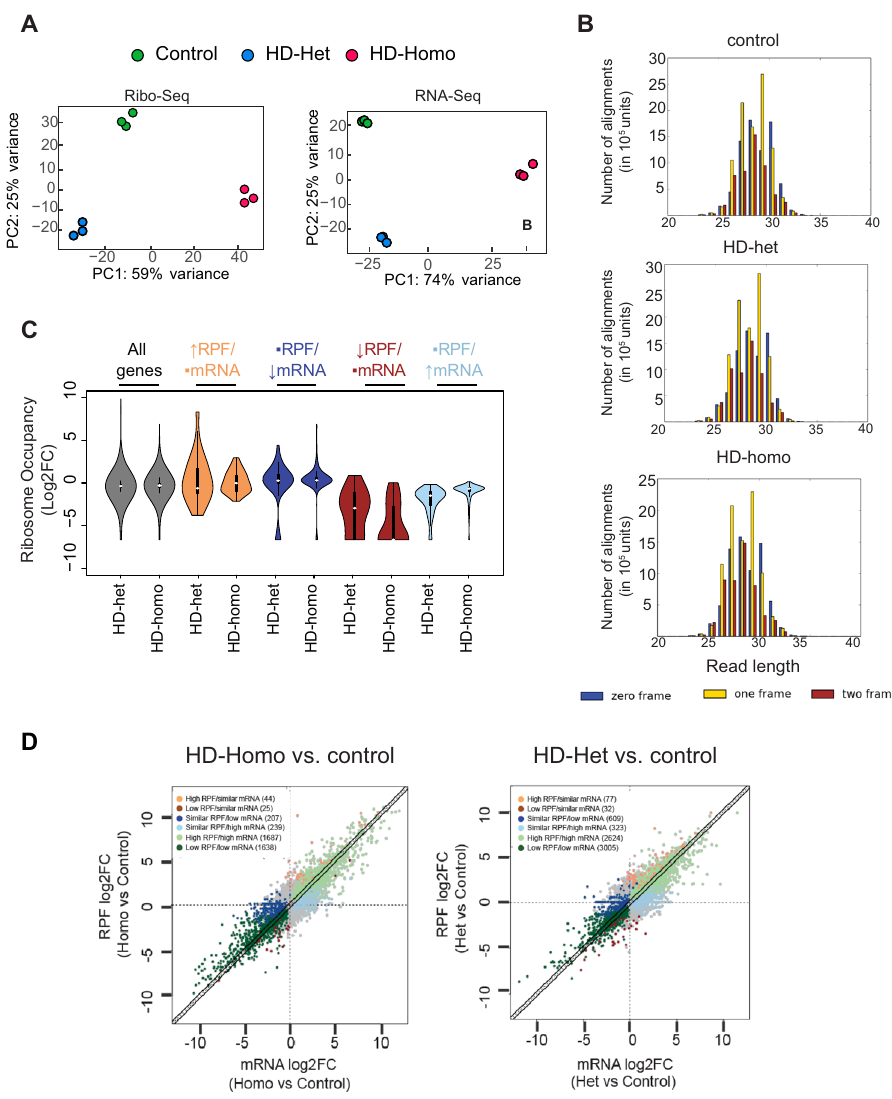
Fig. 7 Global ribosome pro fi ling reveals diverse ribosome occupancy on mRNA transcripts in HD cells. A Principal component analysis using Ribo-Seq and RNA-Seq data obtained from control, HD-het, and HD-homo striatal cells. B Representative graphs showing triplet periodicity plots generated for protein-coding regions of Ribo-Seq data obtained from control, HD-het and HD-homo striatal cells. C Violin plots showing the distribution of ribosome occupancy changes (calculated by the number of Ribo-Seq reads divided by mRNA-Seq reads for each gene, Log2FC) in HD-homo and HD-het cells (compared to control cells). In the middle of each density curve is a small boxplot, with the rectangle showing the ends of the fi rst and third quartiles and central dot the median ( n = 3 independent experiments). D Scatter plots of expression changes of Ribo-Seq vs mRNA-Seq data in control, HD-het, and HD- homo striatal cells. Using Anota2seq, changes in Ribo-Seq are classi fi ed into six groups (see Supplementary Fig. S10A). The numbers of genes in each group are shown at the top left corner of each plot. The total number of genes: 36411, absolute fold change (FC) > 2, nominal P < 0.05, and false discovery rate (FDR) = 0.15. All statistical tests within the anota2seq package are